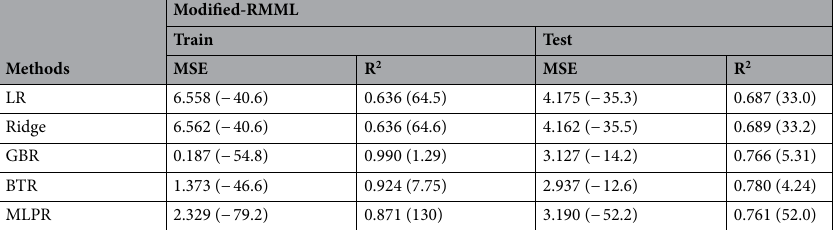
Table 2. Performance of the training and test data of severe fever with thrombocytopenia syndrome cases using the five modified regression models in machine learning (modified-RMML). Parentheses represent the percentage decrease of MSE from the modified-RMML compared to the